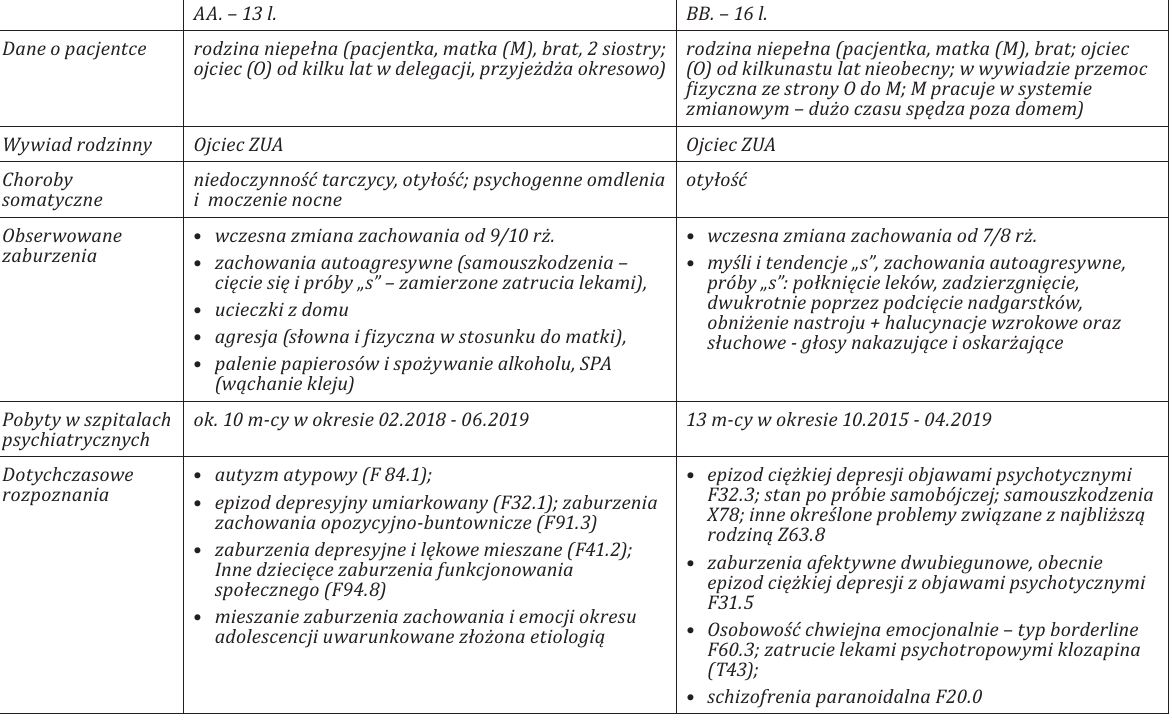
Tabela 2. Zestawienie doświadczanych przez pacjentki zaniedbywani rodzicielskich w oparciu o literaturę – M. Kolankiewicz (2012)